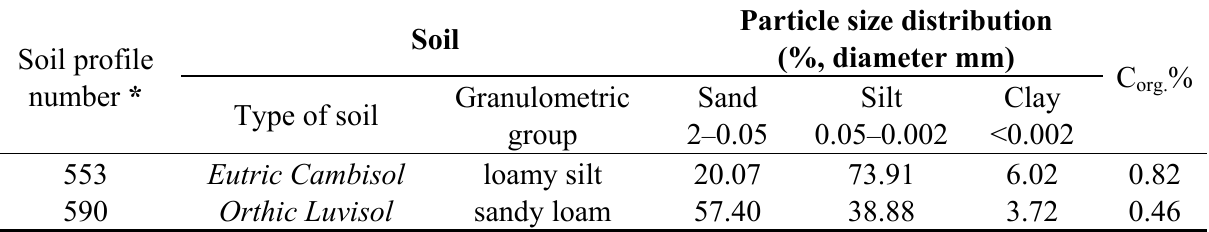
Table 1. Particle size distribution of the soils